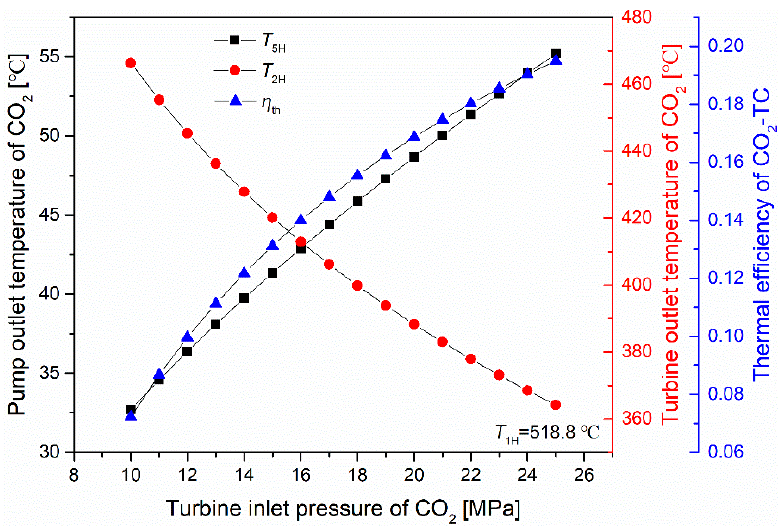
Figure 10. Variations of pump and turbine outlet temperatures and thermal efficiency with turbine inlet pressure of CO 2 for CO 2 -TC.